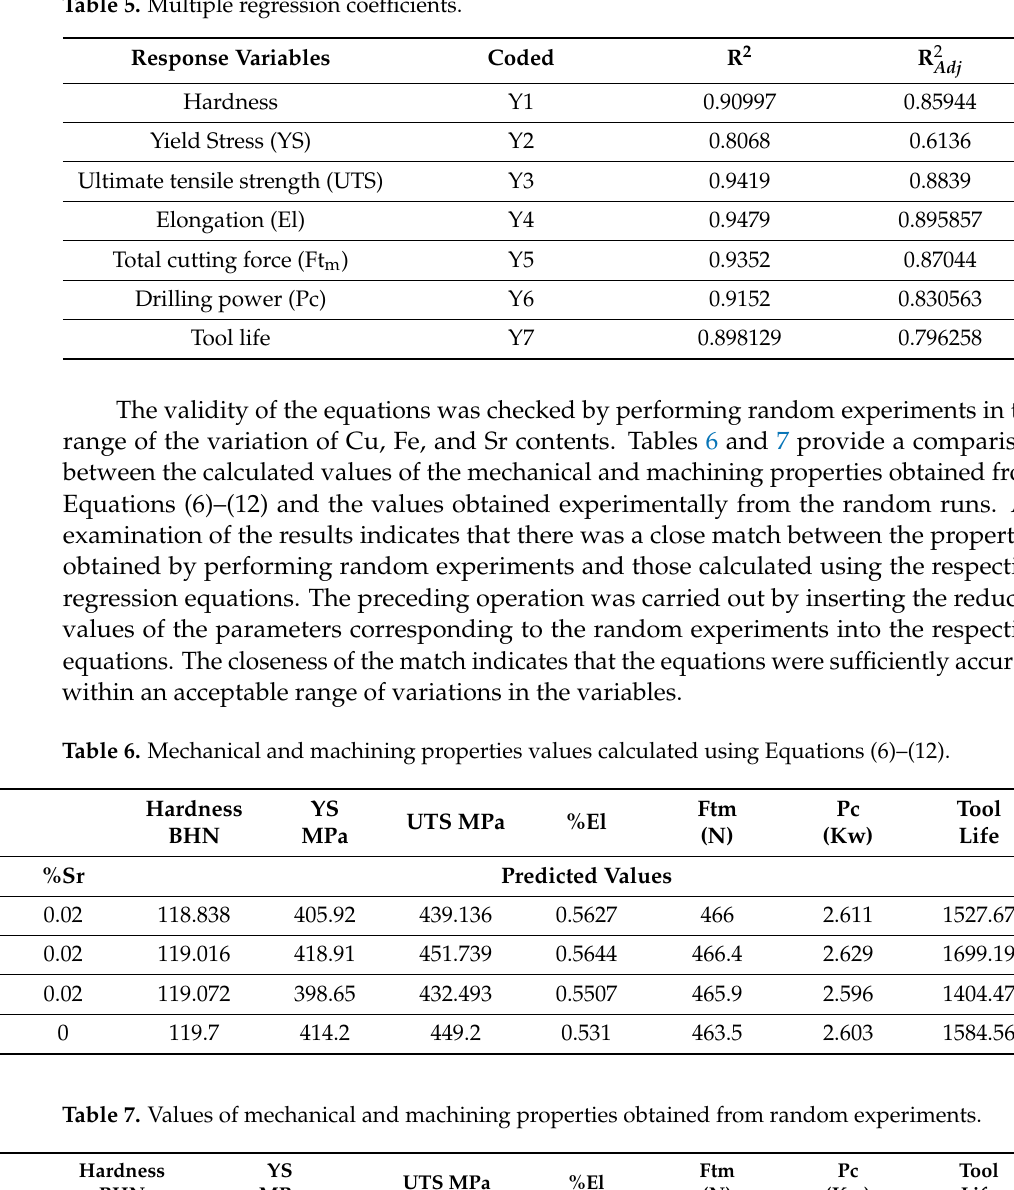
Table 5. Multiple regression coefficients.